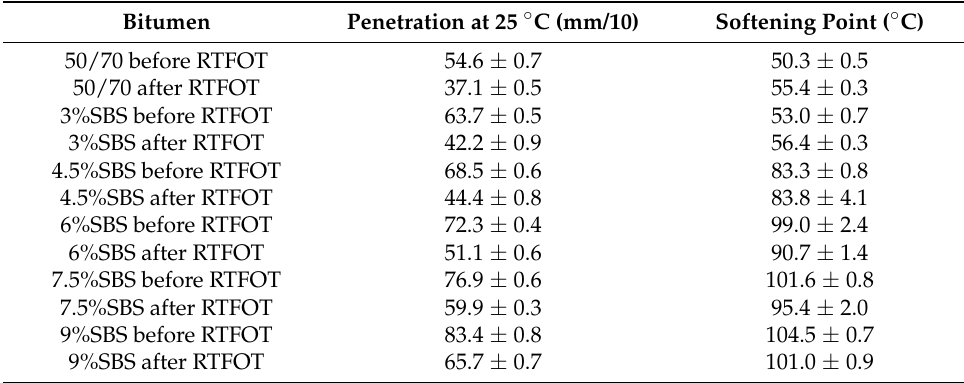
Figure 4. Penetration values of tested asphalt binders. Table 1. Values of penetration at 25 ◦ C and softening